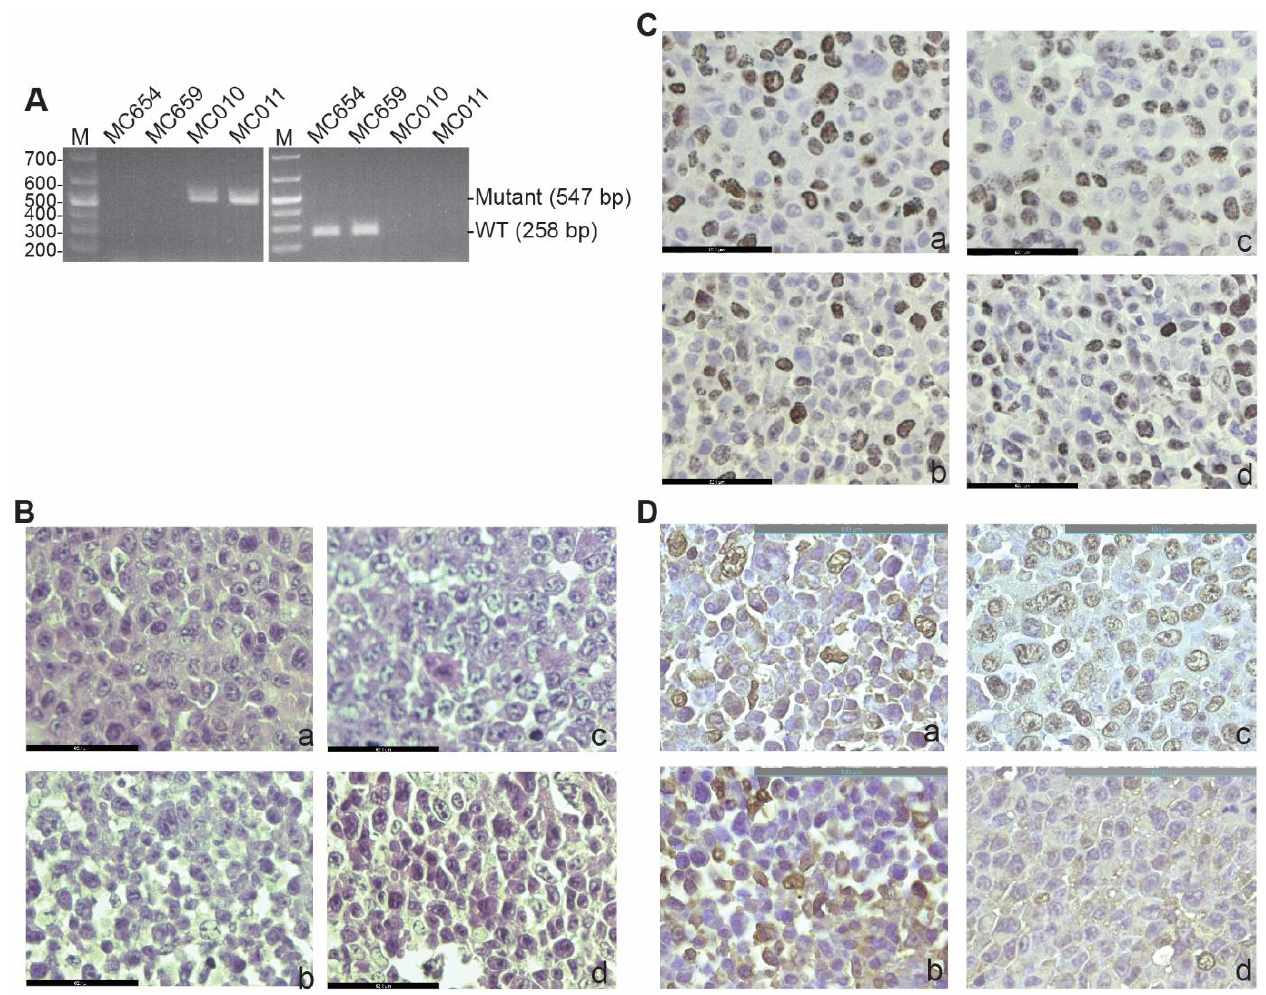
Figure 1. Generation of WT and IRF8 KO tumor cell lines. ( A ) Genomic DNA was isolated from the indicated tumor cell lines and used as a template for PCR-based genotyping with Irf8 WT (left panel) and mutant-specific (right panel) primers, as described in the method. The DNA size markers are indicated to the left of each gel. ( B ) Tumor cell blocks were analyzed by H&E staining. Shown are the tumor cell morphologies. a: MC654, b: MC659, c: MC010, and d: MC011. The scale bar (62.1 µ m) is in the bottom left. ( C ) Tumor cell block sections were analyzed by IHC using Ki67-specific antibody. The brown color indicates Ki67 staining. a–d: same as in ( B ). The scale bar (62.1 µ m) is in the bottom left. ( D ) The tumor cell block sections were analyzed for vimentin by IHC using vimentin-specific antibody. The brown color indicates vimentin staining. a–d: same as in ( B ). The scale bar (100 µ m) is in the top right.